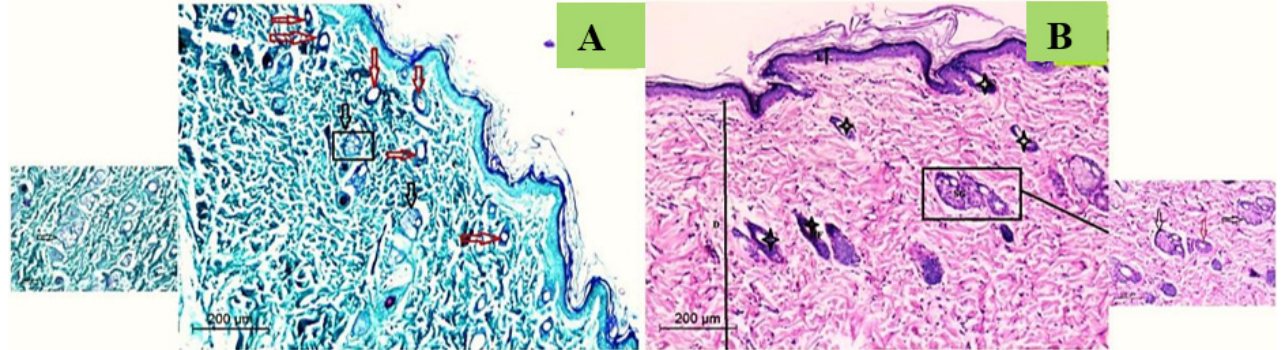
Figure 10. Photomicrograph of histological appearance of normal rat skin stained with Massons Trichrome ( A ) and H&E ( B ), Magnification 200×. Transparent black arrows refer to sebaceous gland; transparent red arrows refer to sweat gland; strikes refer to mature hair follicles.